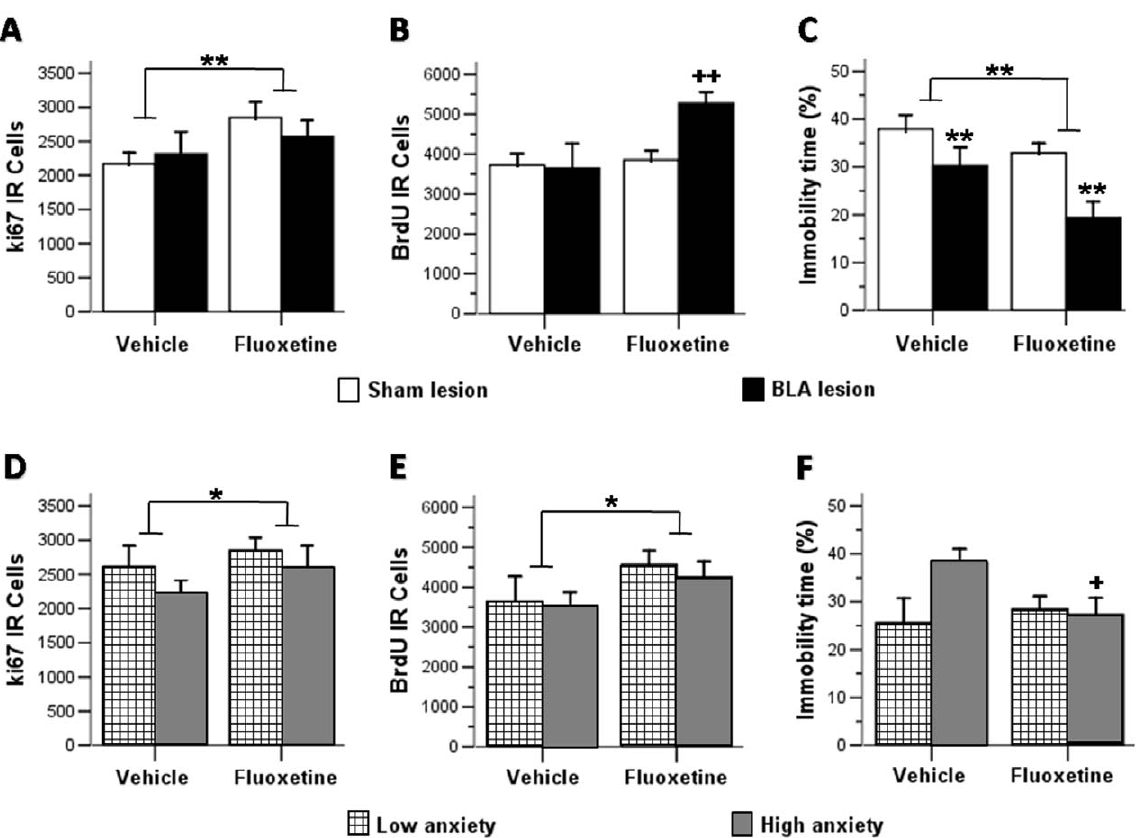
Figure 2. Effects of chronic treatment with fluoxetine on levels of cell proliferation and survival in the dentate gyrus of the hippocampus and depression-like behavior during the forced swimming test after neurochemical lesions of the basolateral complex of the amygdala (A,B,C) and according to anxiety (D,E,F). Error bars represent the standard error of the mean. [**p , 0.01, *p , 0.05 vs. corresponding vehicle group (ANOVA main effect); ++ p , 0.01, + p , 0.05 vs. corresponding vehicle group (ANOVA simple main effect).